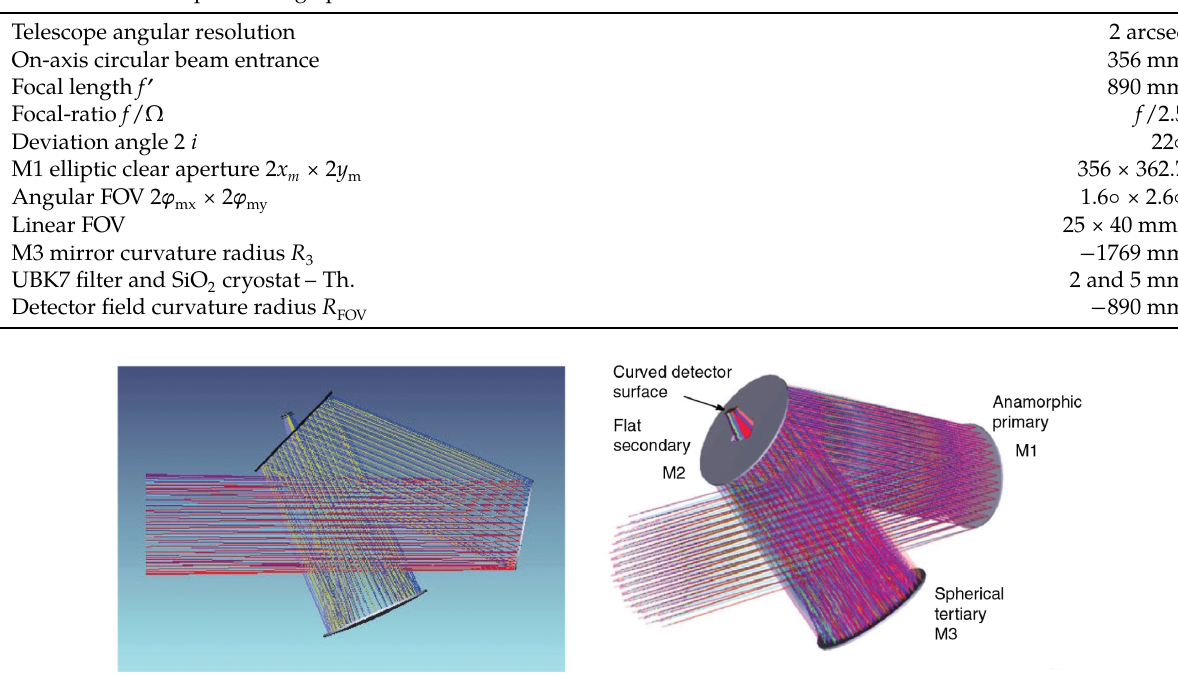
Table 1: MESSIER optical design parameters.